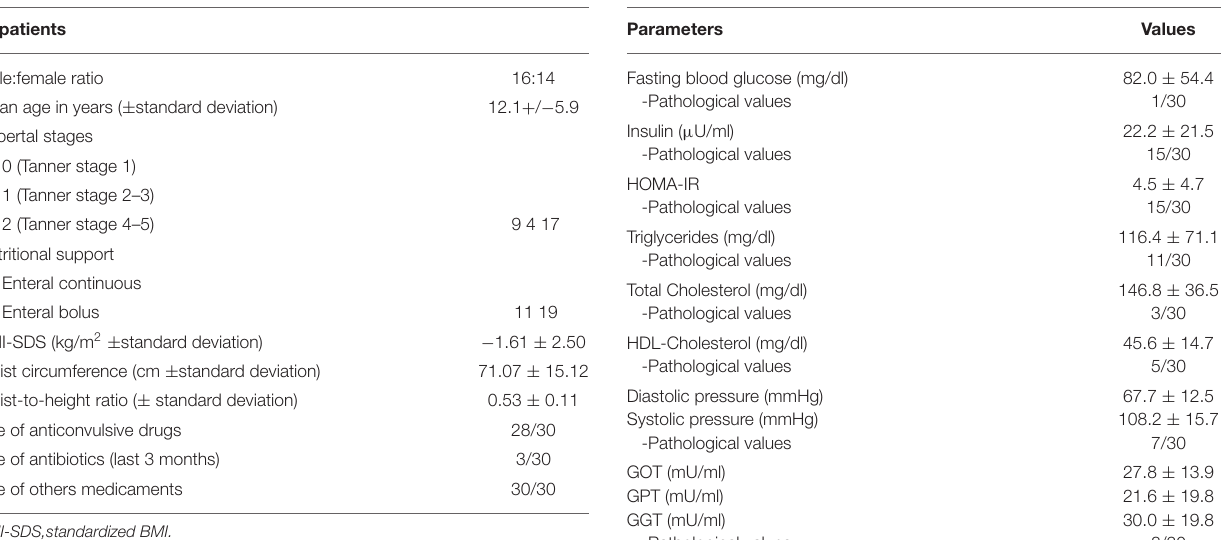
TABLE 2 | Metabolic parameters of patients with neurological impairment